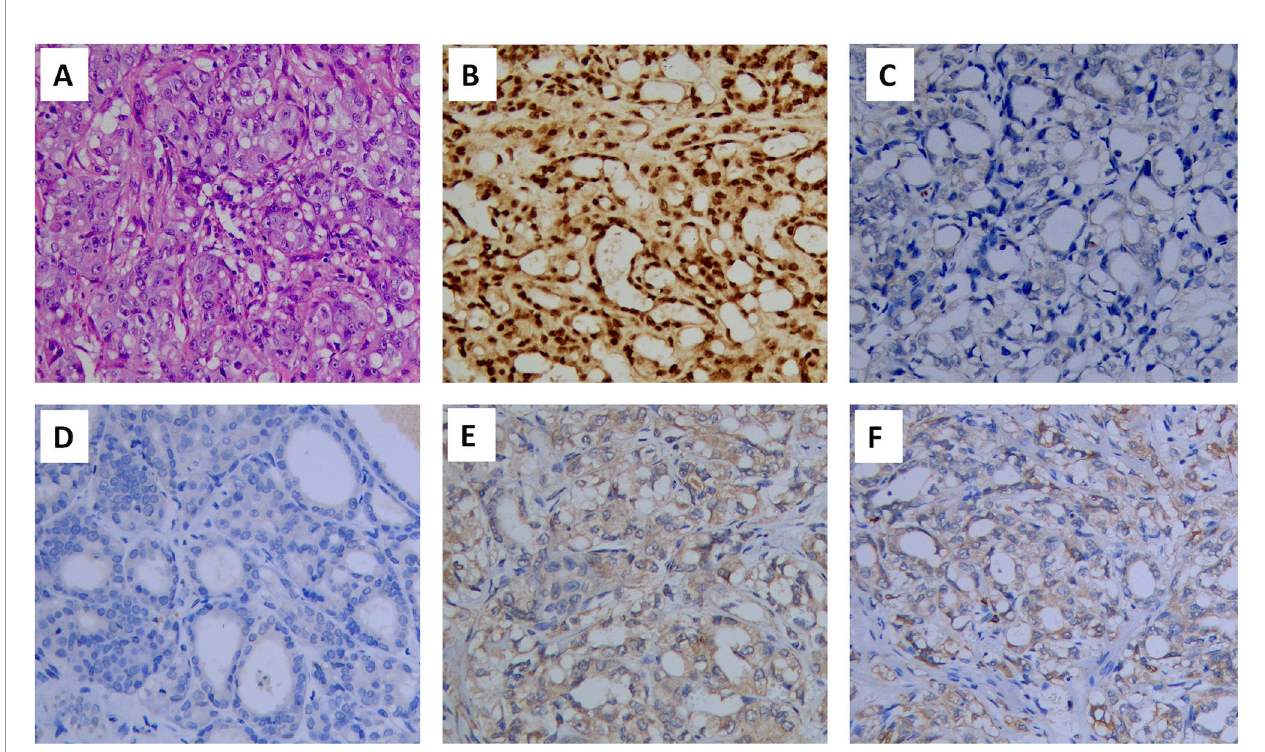
FIGURE 2 | Hematoxylin and eosin (HE) staining and immunohistochemical staining of the renal tumor (×200): (A) HE staining, (B) PAX8 (positive), (C) p63 (negative), (D) CD10(negative), (E) vinculin (positive) and (F) PD-L1(positive). PAX8, paired box 8; PD-L1, programmed cell death 1 ligand